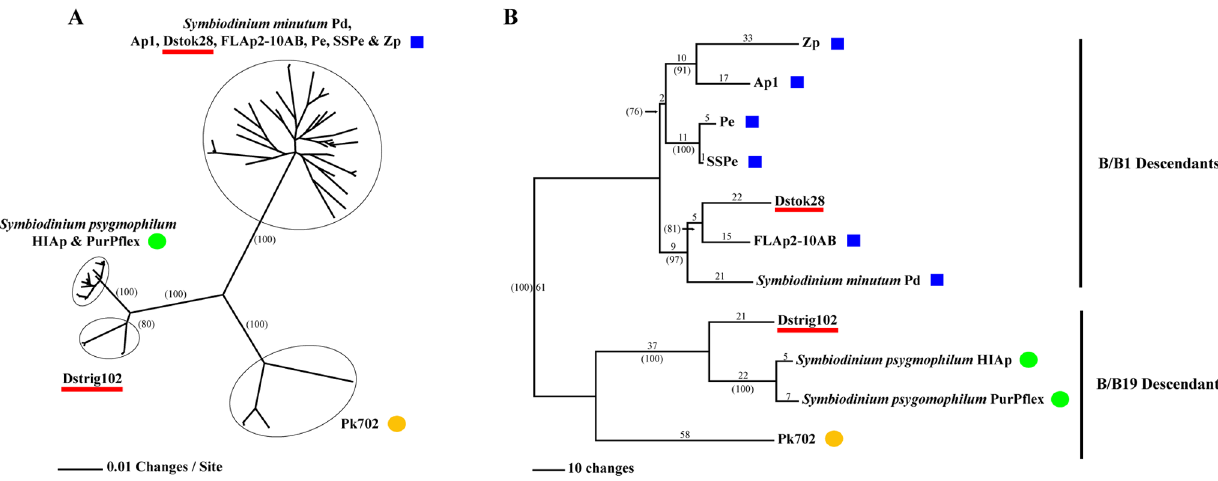
Figure 3. Phylogenies of Symbiodinium clade B long sPCP cassette sequences. (A) Maximum likelihood tree of all non-chimeric clones. (B) Most parsimonious tree of most frequently recovered non-chimeric clones. Branch lengths for the most parsimonious tree are shown above the branches. Support values . 70% based on + 1000 bootstrap trees are shown in parentheses. Support values for minor branches of the maximum likelihood tree are not displayed. Blue squares=B/B1/B184; Green circles=B/B2/B224 (descendant of B/B19); Orange circles=B/B19/B211. The positions of Dstok28 and Dstrig102 are underlined in red. The topologies of both trees are congruent with each other.